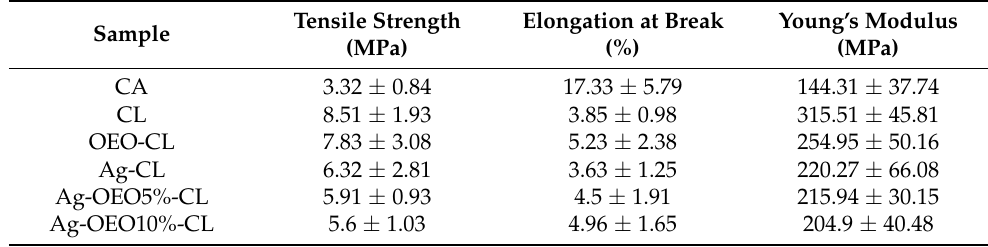
Table 3. Tensile strength, elongation at break, and Young’s modulus of CA, CL, OEO-CL,